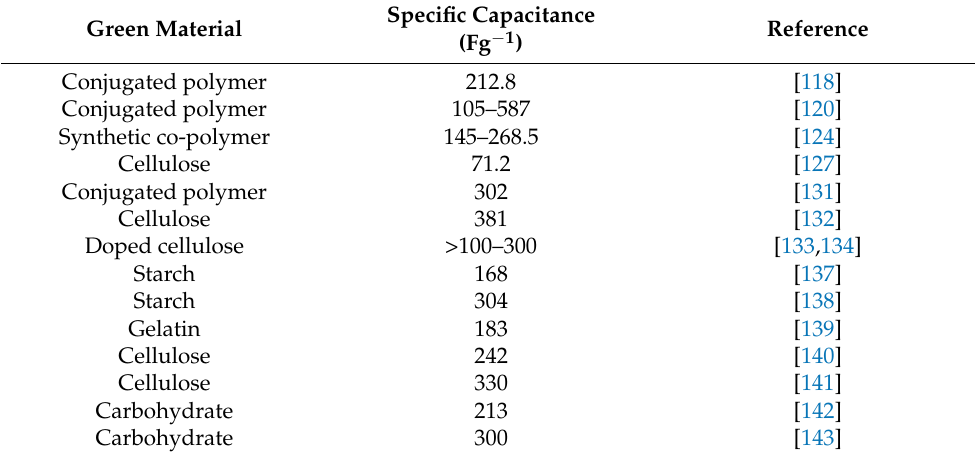
Table 3. Performance of green supercapacitor electrode